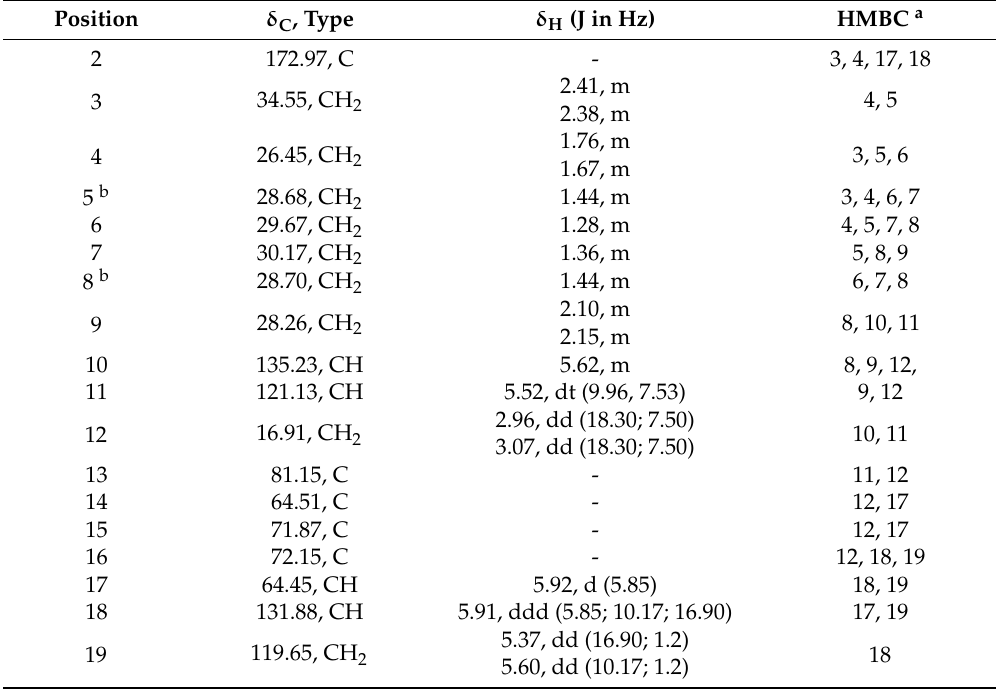
Table 2. NMR spectroscopic data (500 MHz, CDCl 3 ) for Campestrolide ( 33